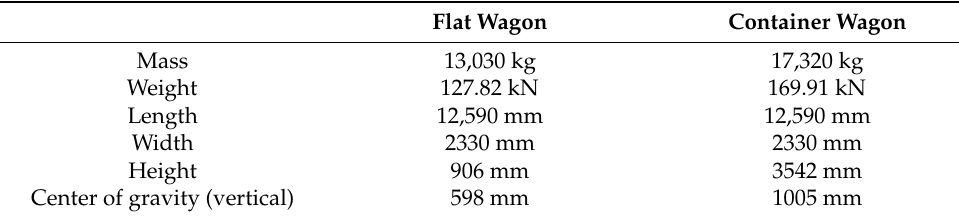
Figure 5. Test freight car units: ( a ) flat wagon and ( b ) container wagon. Table 2. The specification of the flat and container wagons.